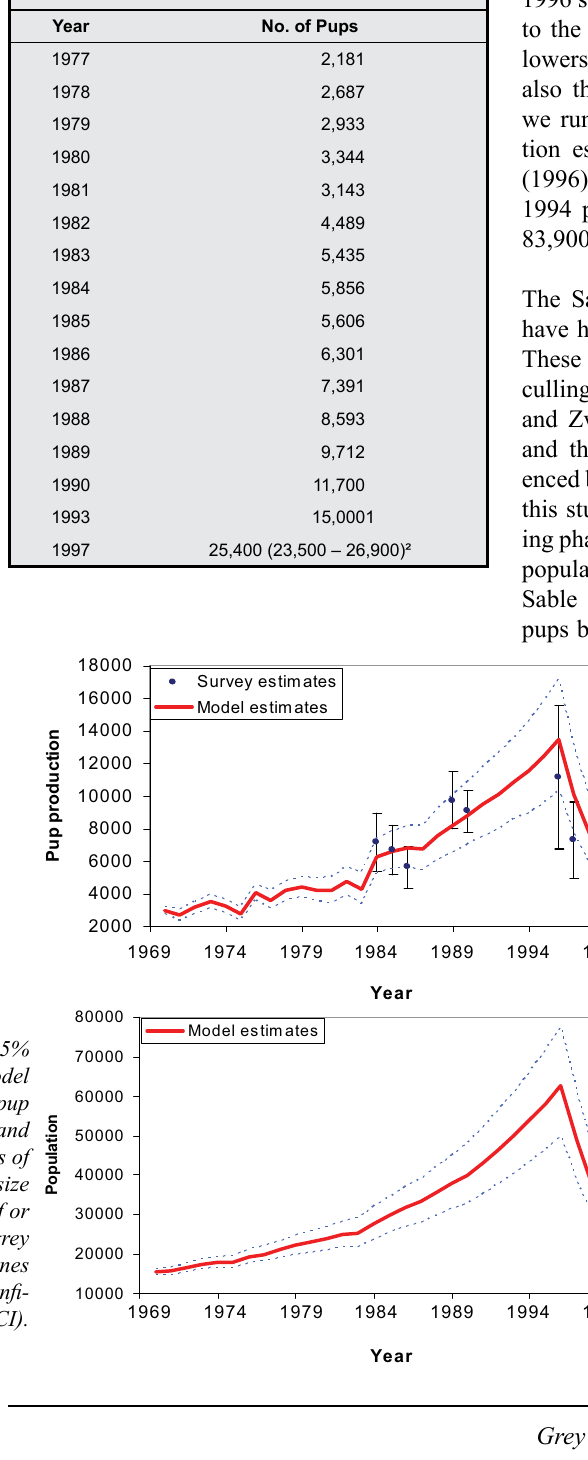
Table 9. Estimates of Sable Island grey seal pup production. Pup production from 1977 – 1990 are total counts (Stobo and Zwanen- burg 1990), the 1993 and 1997 are estimates from photographic aerial surveys (Mohn and Bowen 19961; Bowen et al. 20032). 95% C.I. are in brackets.